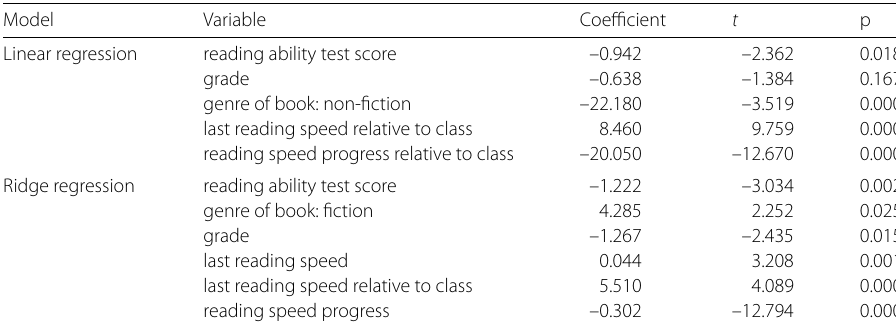
Table 7 Standardized coefficients from the linear and ridge regression models on reading speed progress and associated t - and